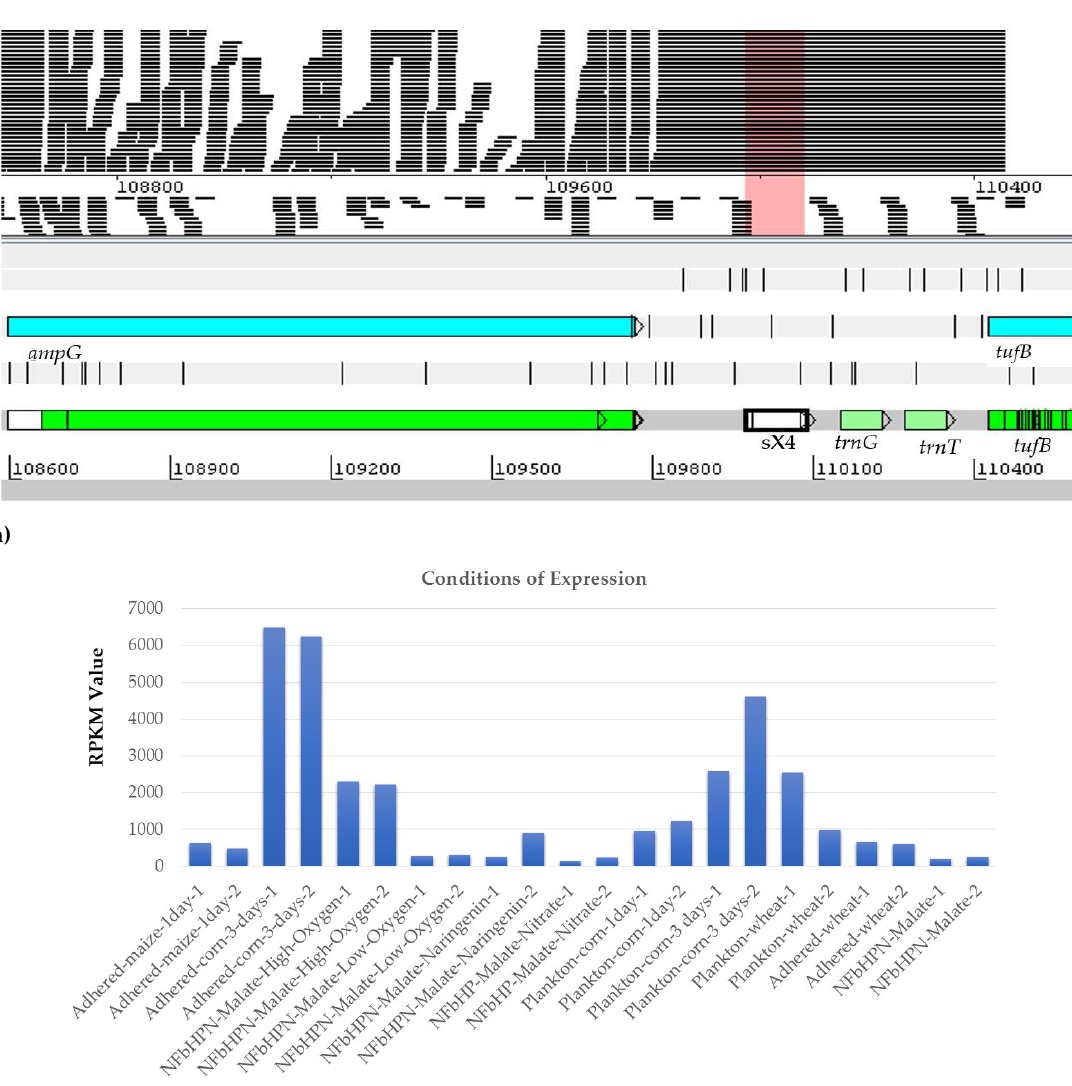
Figure 4. Visualization of the position and expression profile of the sX4 ncRNA in the genome of H. seropedicae SmR1. The sequence was located by means the Artemis program. The readings delineated by the pink rectangle are as follows: ( a ) Levels of sX4 ncRNA expression in RNA-seq assays in H. seropedicae SmR1. In the colored section, the 11 analyzed experimental conditions are represented, where 1 and 2 represent d.a.i (days after inoculation); ( b ) the numbers represent the value of the gene expression in RPKM.